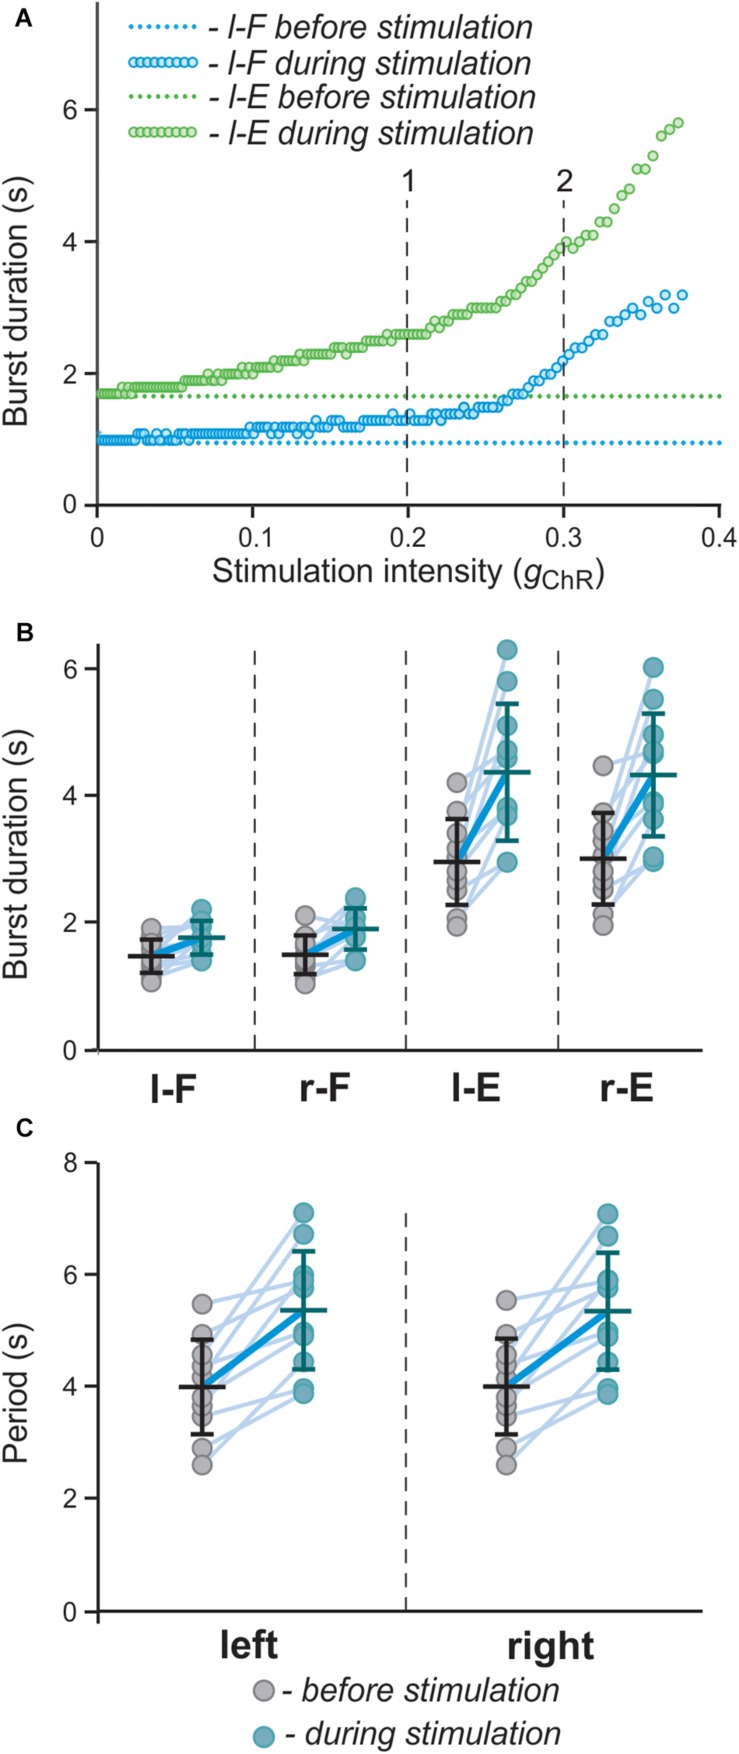
Effect of bilateral stimulation of V3 interneurons on flexor and extensor burst duration s and oscillation period in the model. (A) Dependence of flexor and extensor burst duration on stimulation intensity (gChR; shown for the left side only). Intensity of stimulation was gradually changed from 0 to 0.4. The vertical lines (1 and 2) correspond to simulations shown in Figures 8A1,A2, respectively. (B,C) Flexor and extensor burst duration and period of oscillations in a series of model experiments (n = 12) with randomly chosen parameters α and gChR before (gray circles) and during (blue circles) bilateral stimulation of V3 populations. Each circle represents the average value of estimated parameter for one simulation. Light blue lines connecting two circles represent parameter increase in one simulation Thick, dark blue line represent the average of increase.